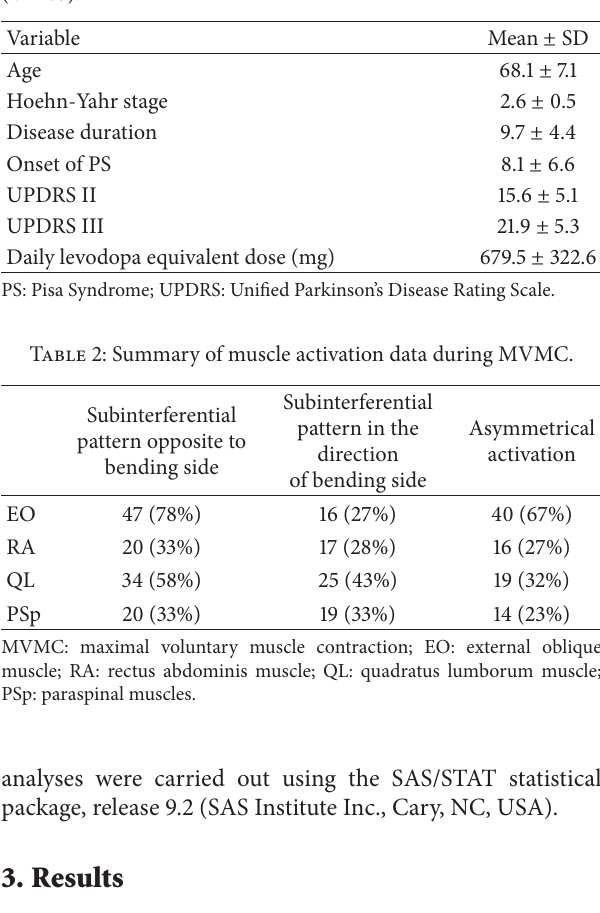
Table 1: Clinical and demographic data for the study population ( 𝑛 = 60 ).